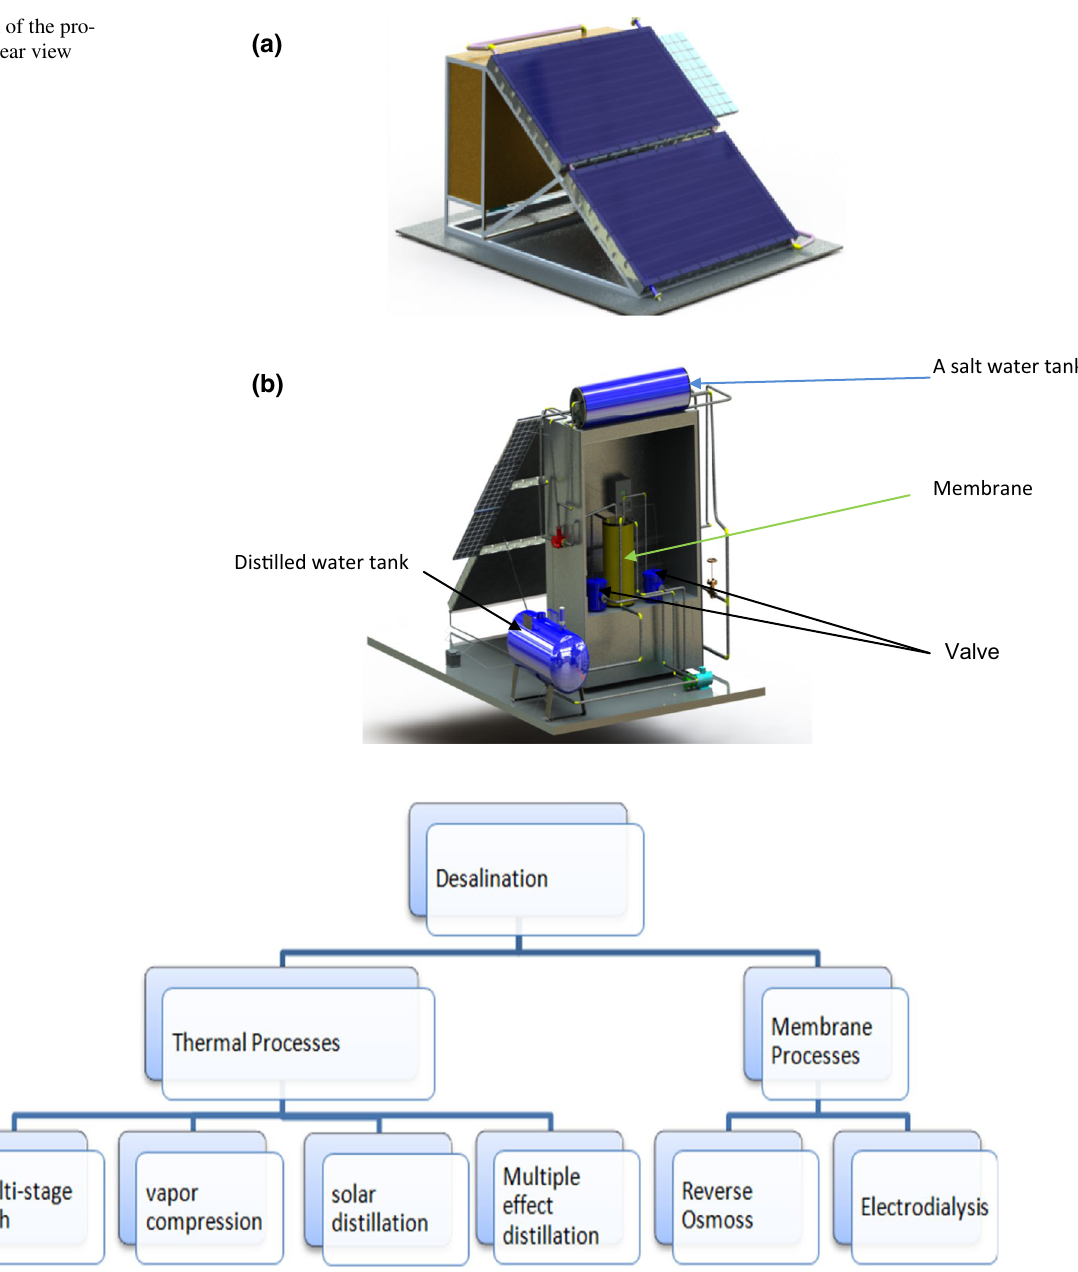
Air gap membrane distillation (AGMD) is shown in Fig. 3c. Related to the PGMD channel configuration, the permuate is separated from the coolant by an impermeable film next to the membrane on the permeate side. Due to a temperature difference, the volatile compounds of the feed solution evaporate at the feed side liquid–vapor interface, pass the membrane and the air gap in the gaseous phase and condense at the liquid–vapor interface on the cooled surface